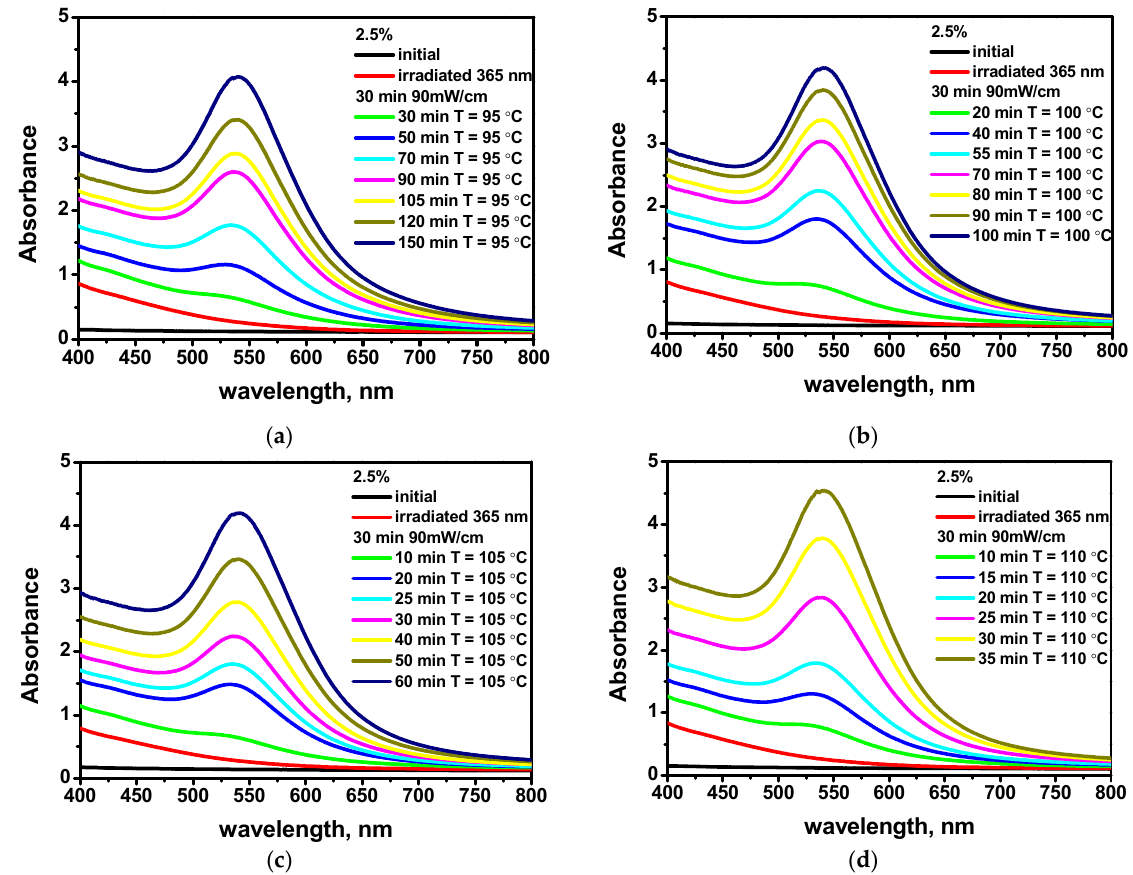
Figure 3. Absorbance of samples of polystyrene + 2.5 wt % (Ph 3 P)Au( n -Bu): initial, after irradiation and after further heating at temperatures of ( a ) 95 °C, ( b ) 100 °C, ( c ) 105 °C, and ( d ) 110 °C. An HRTEM micrograph of the LED-irradiated sample is presented in Figure 4a, showing an accumulation of nanoparticles with sizes of about 10–20 nm. All particles have a well-defined crystal structure. The inset in the upper right corner of the Figure 4a is an enlarged fragment of the image of one of the selected particles, which clearly shows the crystal lattice with the parameter of 0.204 nm. This parameter corresponds to the distance between crystal planes (200) of metallic gold. The selected area electron diffraction (SAED) of this cluster of nanoparticles (Figure 4b) also corresponds to lattice constants d 1 = 0.235 ± 0.003 nm, d 2 = 0.204 ± 0.002 nm, d 3 = 0.144 ± 0.002 nm, and d 4 = 0.123 ± 0.002 nm, which can be indicated as reflections of the planes with indices (111), (200), (220), and (113), respectively, for metallic Au lattice.